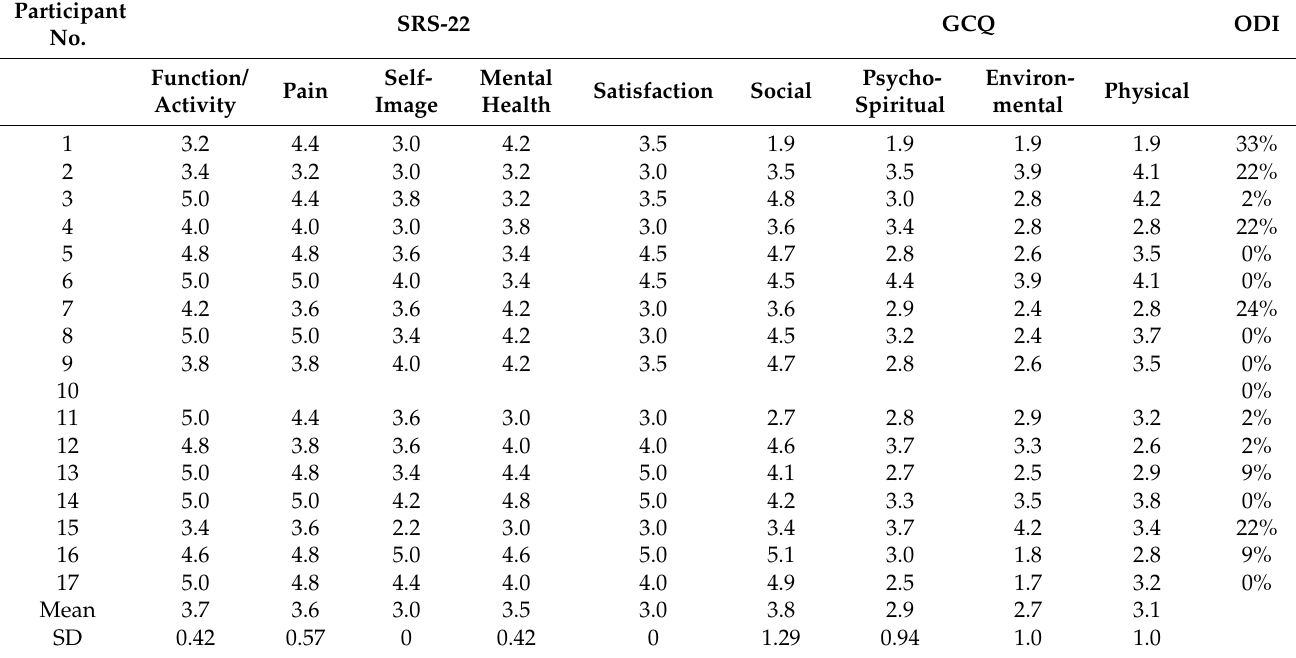
Table 3. Participants’ domain scores at the SRS-22, GCQ and ODI.